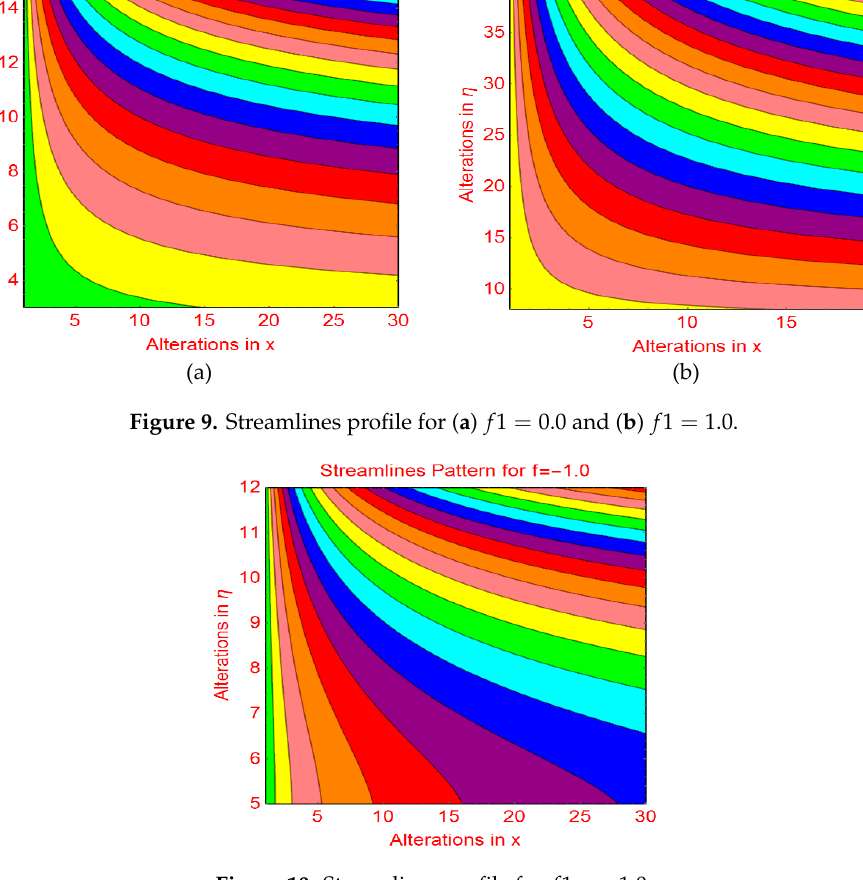
Figure 10. Streamlines profile for 𝑓1 = −1.0